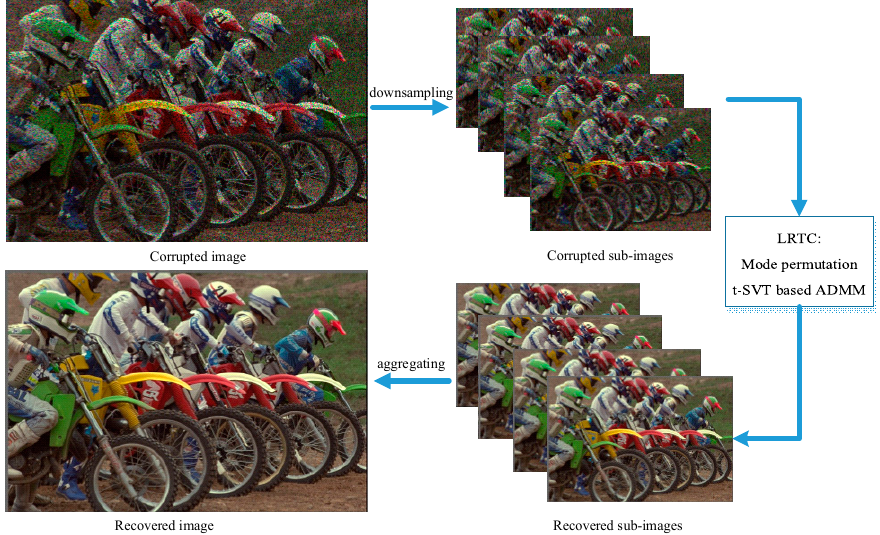
Figure 5. Flowchart of the proposed framework. The downsampling method is as shown in Section 3.1. After the mode permutation of the sub-images, t-SVT is performed to obtain the recovered sub-images. Finally, the final recovered image can be obtained by aggregating the recovered sub-images.